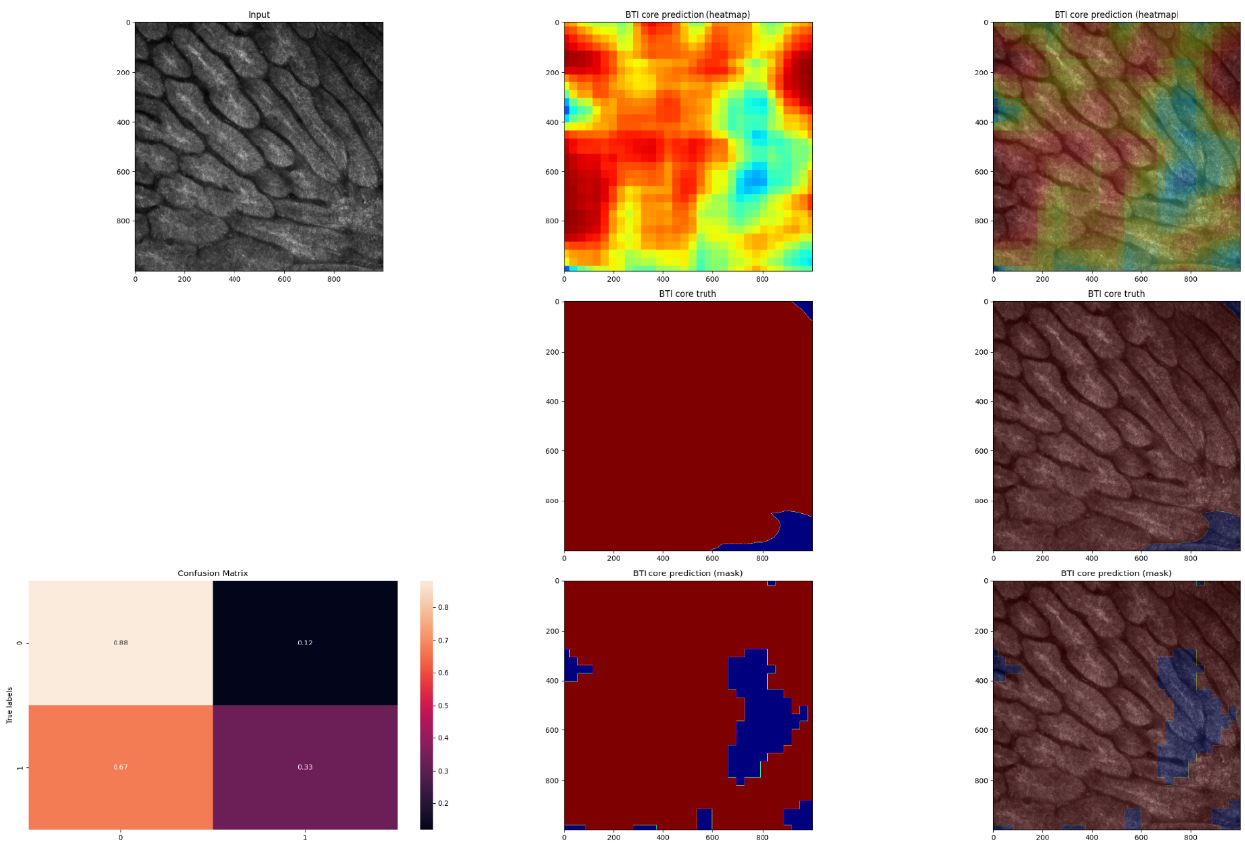
Figure 8. Fourth example of an in vivo RCM image of a BCC, with cancerous regions manually annotated and automated predictions. An image of the predicted heatmap can also be seen in the image. Jet is a colormap that ranges from blue to red, where the former represents SCC and the latter, non-SCC. Using the methodology described in the Materials and Methods section, image shows the prediction mask generated from the heatmap. Additionally, a normalized confusion matrix is shown for each row. The class that is not SCC is represented by, and 1 represents the class that is SCC. As we can see, this is an average-performing example. This is another better-performing example; the majority of the cancerous regions were predicted correctly.